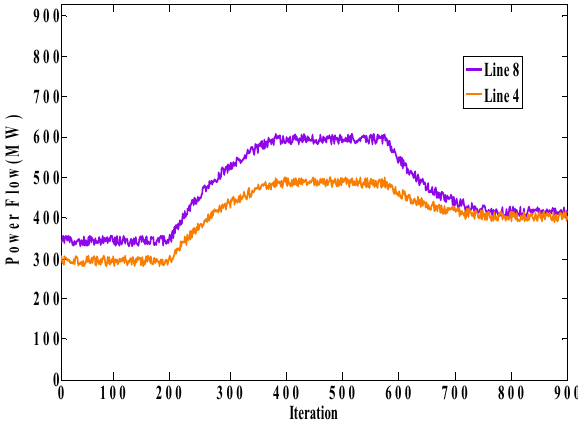
Figure 13. Power flows of Lines 4 and 8 in Case B.